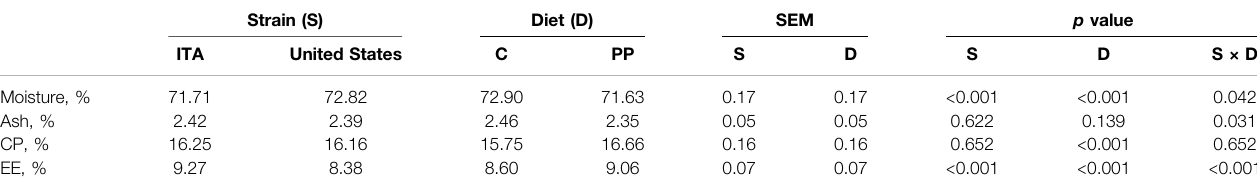
TABLE 3 | Final whole-body proximate composition (as is) of the rainbow trout depending on strain, diet, and their interaction ( n = 5). Strain (S) Diet (D) SEM p value